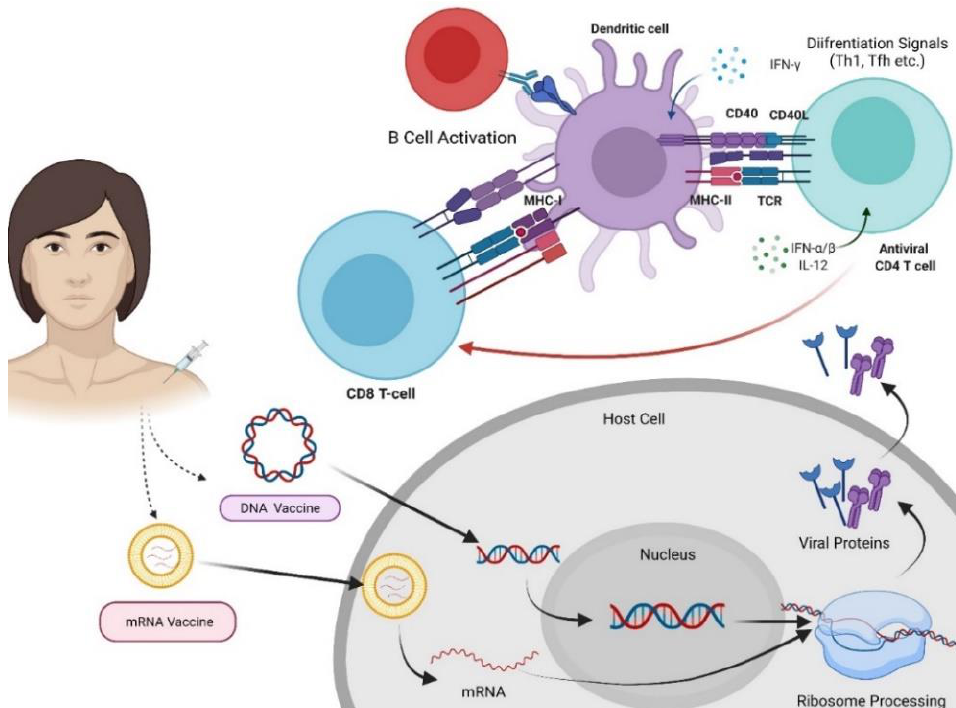
Figure 3. Mechanism of nucleic acid vaccine to generate immune protection post-vaccine jab.